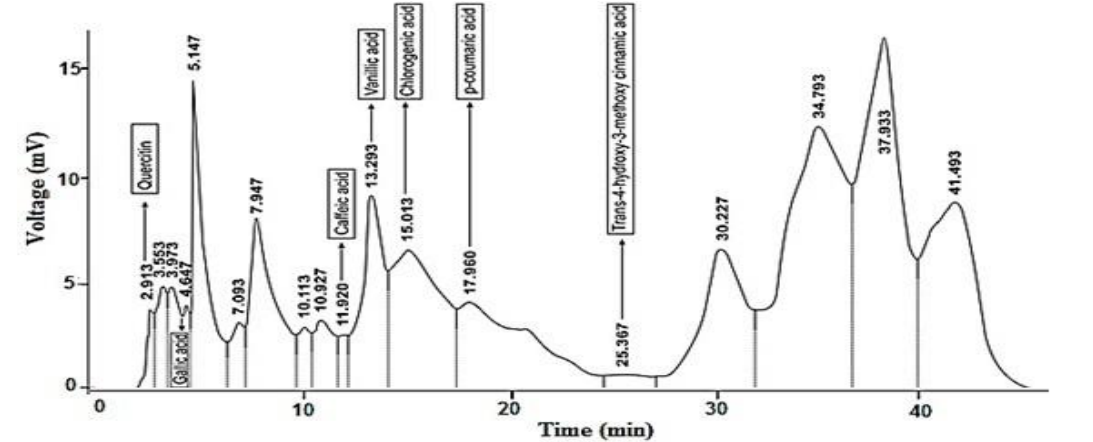
Figure 1. HPLC chromatogram of phenolic components of ethyl acetate fraction of B. calliobotrys. Table 3. Effect of B. calliobotrys on in vitro anti-glycation activity. Treatment Groups